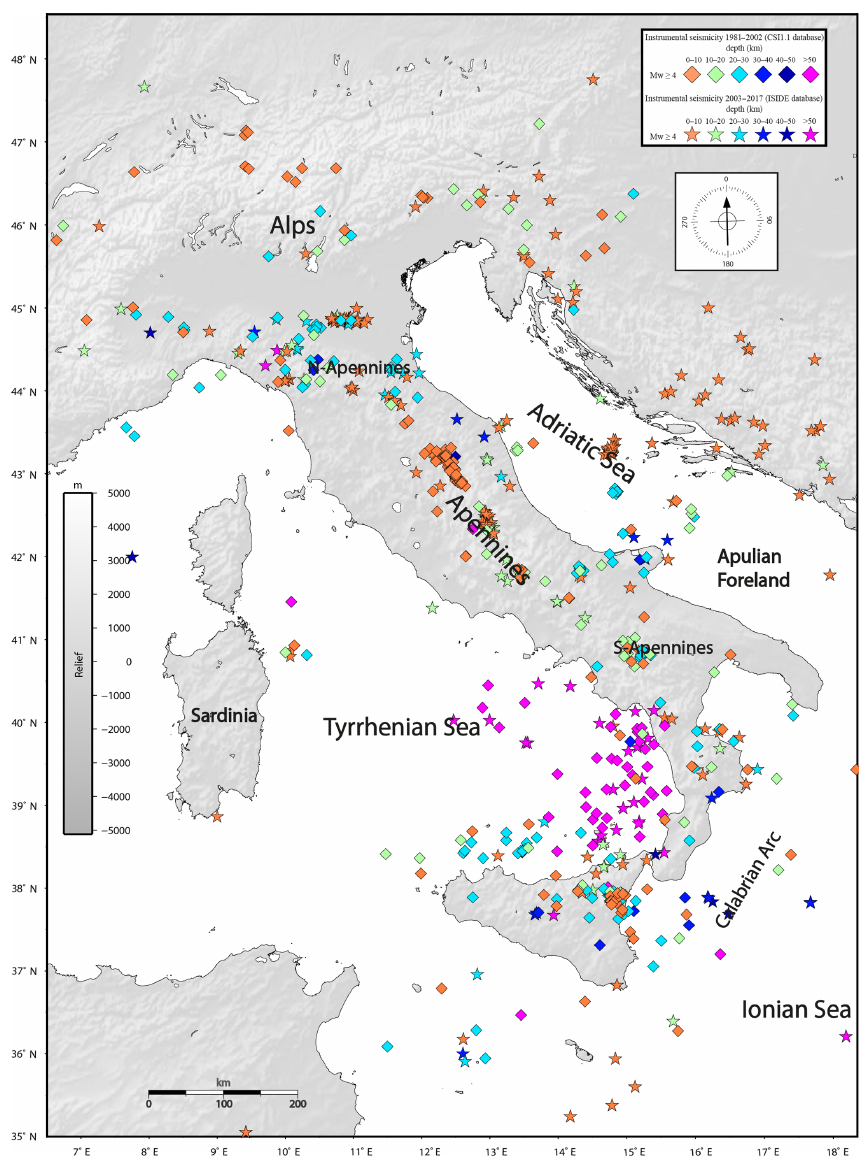
Figure 3. Instrumental seismicity (epicentres of M w ≥ 4 . 0 earthquakes) distribution in Italy from ISIDe (stars) and CSI (diamonds) datasets. The CSI1.1 database (http://csi.rm.ingv.it, last access: 29 August 2019; Castello et al., 2006) reports events in the 1981–2002 time interval, whereas the ISIDe database (http://iside.rm.ingv.it/iside/standard/index.jsp, last access: 29 August 2019; Iside Working Group, 2016) reports events in the time interval 2003–2017. Events are differentiated by depth (change in colour every